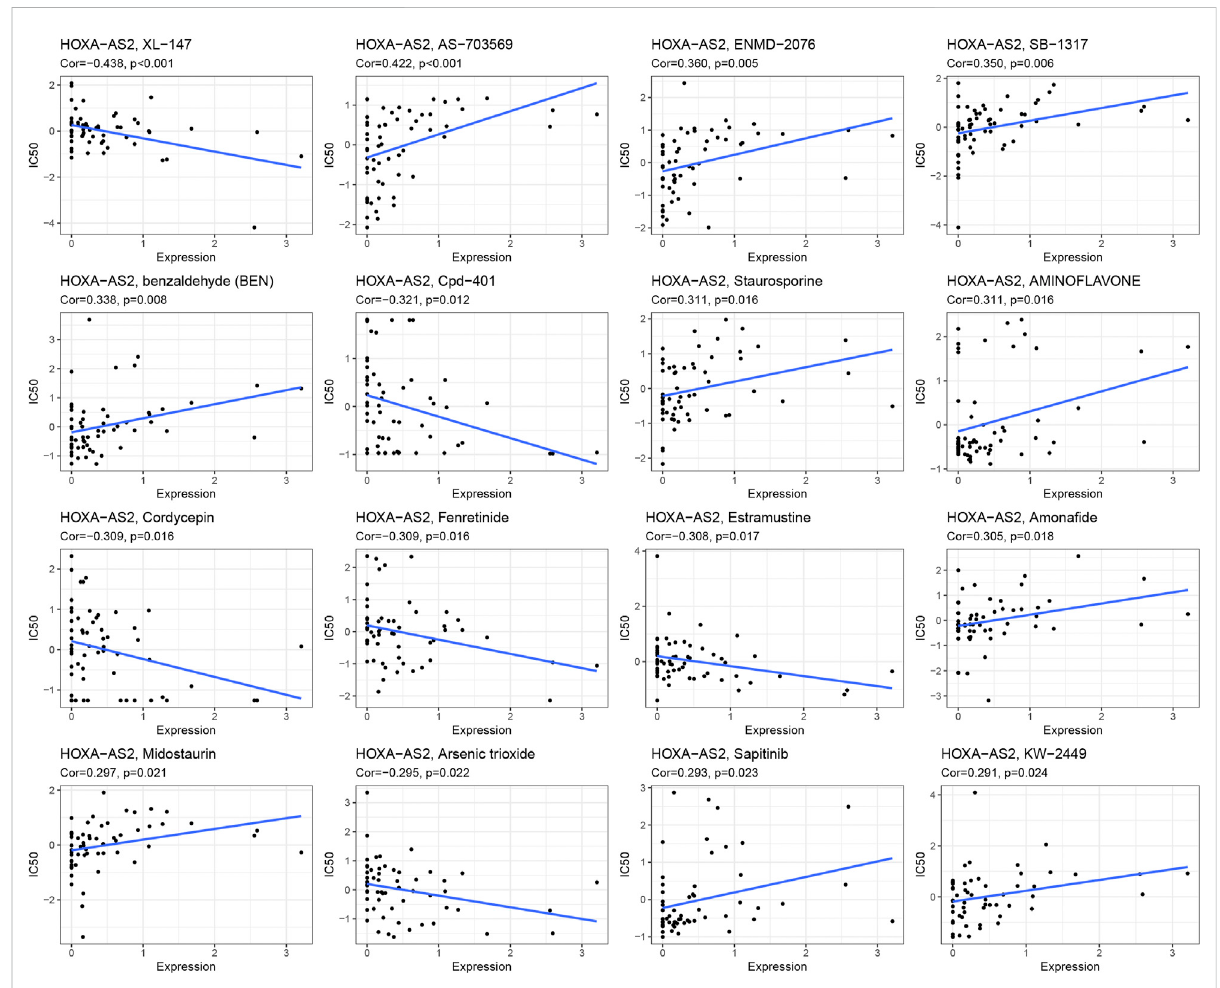
FIGURE 6 An illustration of the association between HOXA-AS2 expression and expected medication